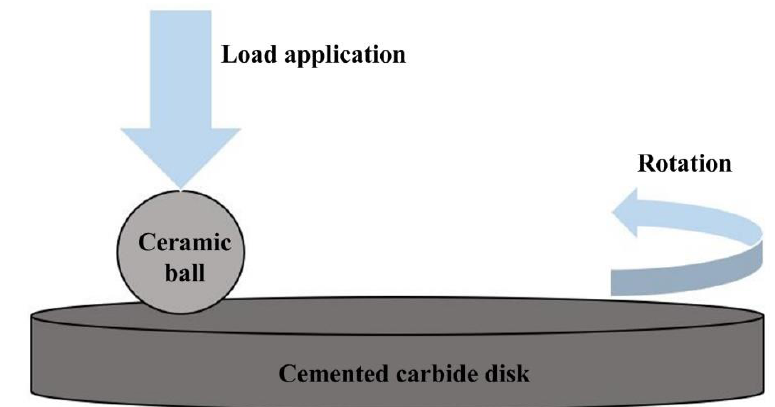
Figure 3. Schematic diagram of the friction and wear test.